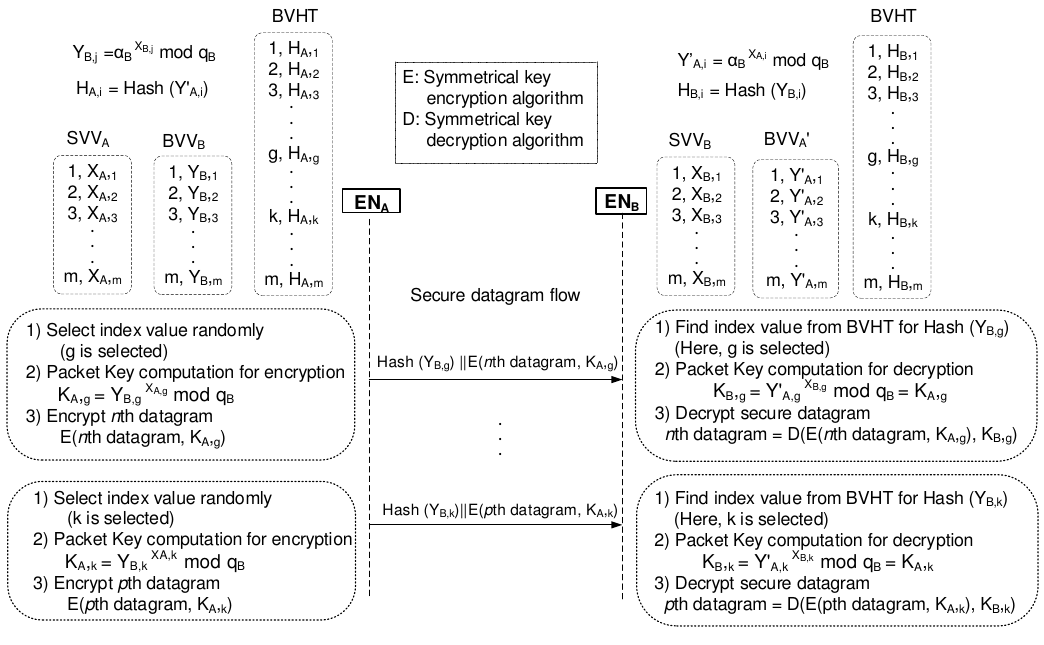
Figure 11. Packet key encryption and decryption for the secure datagram